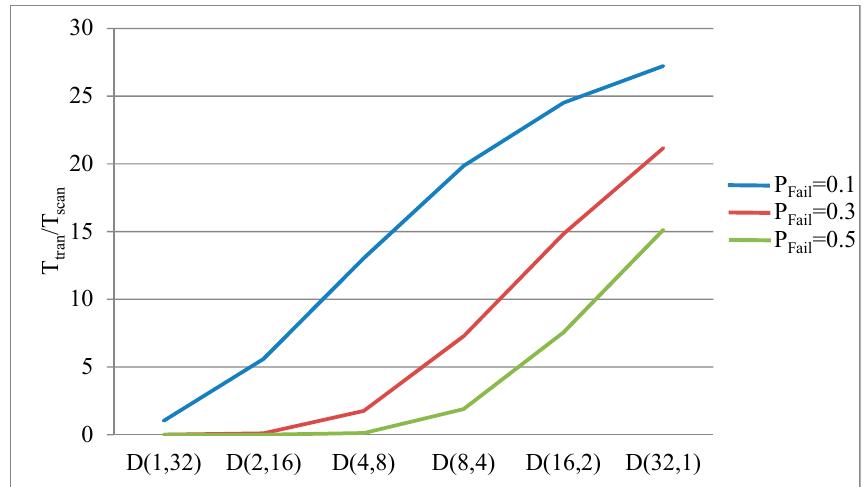
Figure 11. The influence of β on the probability of secondary user (SU) transmission failure in full scan mode.